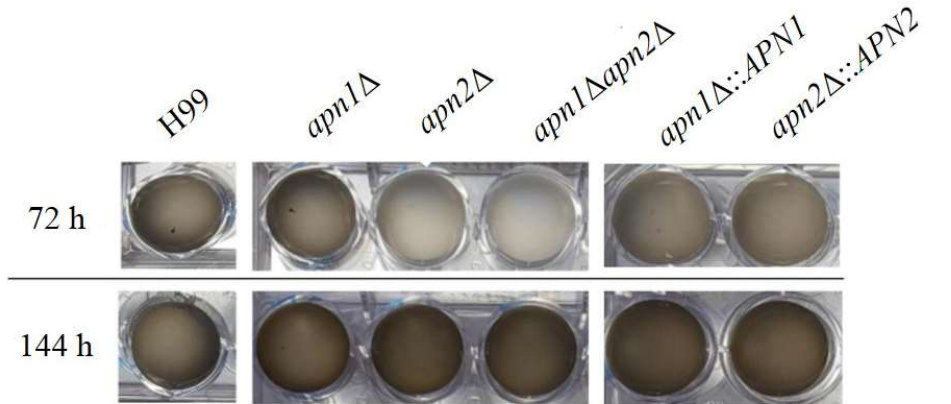
Figure 6. The disruption of the Apn2-like gene of C. neoformans impairs melanin production. C. neoformans yeasts were incubated in melanin-inducing minimal medium with 1 mM L -DOPA at 37 °C, 150 rpm, protected from light. Melanin production was visually assessed by the medium color change from translucent to brown and photo-documented at 72 and 144 h. The result is representative of three independent experiments.